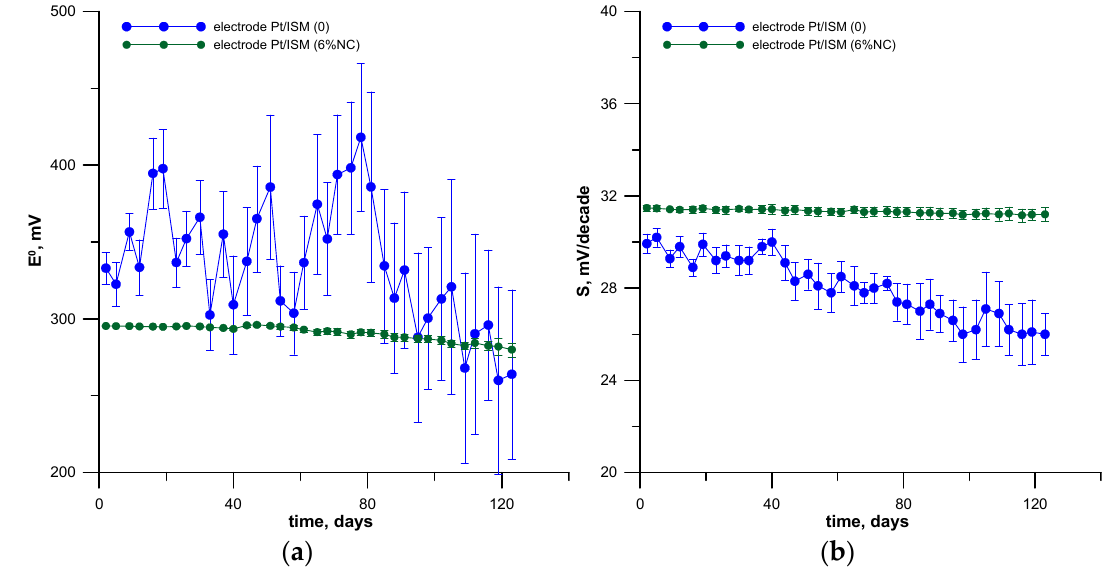
Figure 5. Change of electrode parameters over time for the unmodified electrode (Pt/ISM (0)) and the modified one with the nanocomposite (Pt/ISM (6%NC): ( a ) E 0 and ( b ) slope of linear section of response function. Standard deviations given on the plots are determined for the same three elec- trodes of the two electrode types, i.e., Pt/ISM (0) and Pt/ISM (6%NC), respectively.